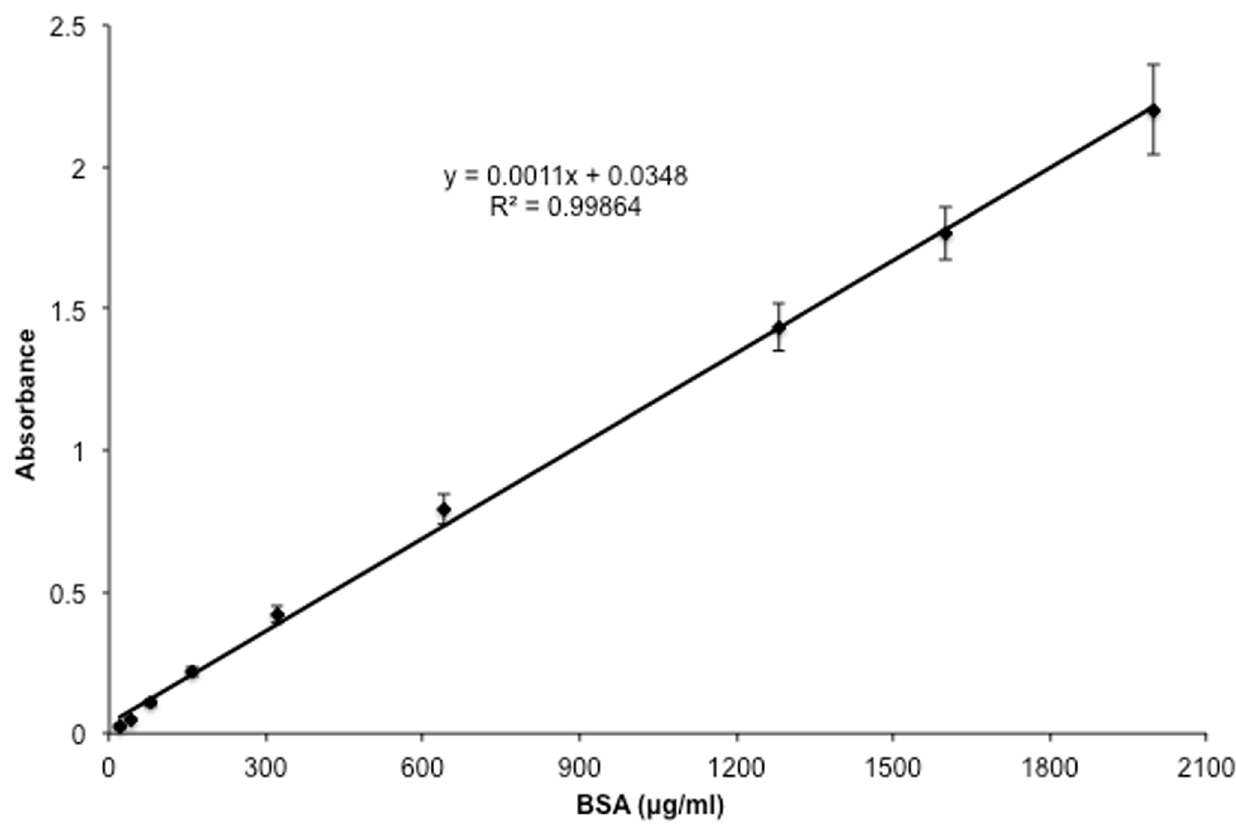
Figure 2. Representative mean calibration plots generated using the BCA method for determination of BSA content (means ± S.D., N=7).